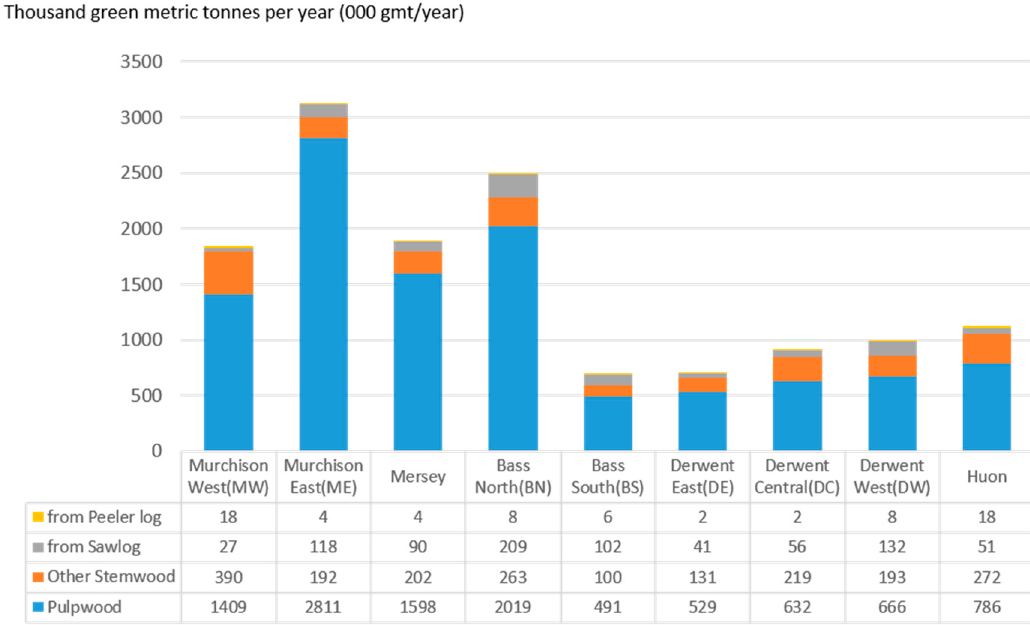
Figure 2. The forecast Tasmania state-wide residue flow estimates annually in thousand green metric tonnes per year in the 2014 to 2019 period.